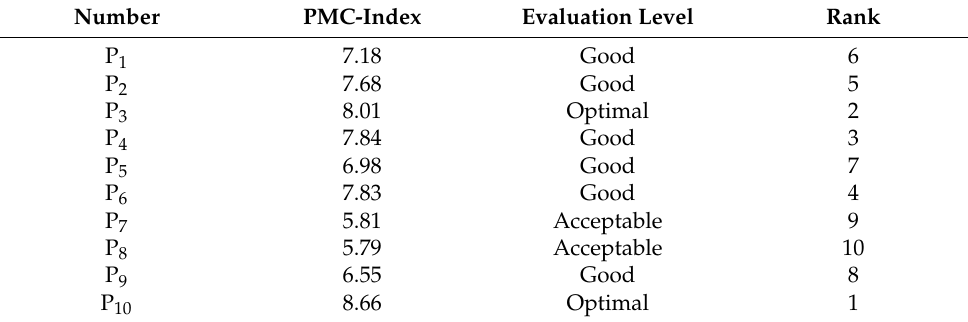
Table 6. Rank of